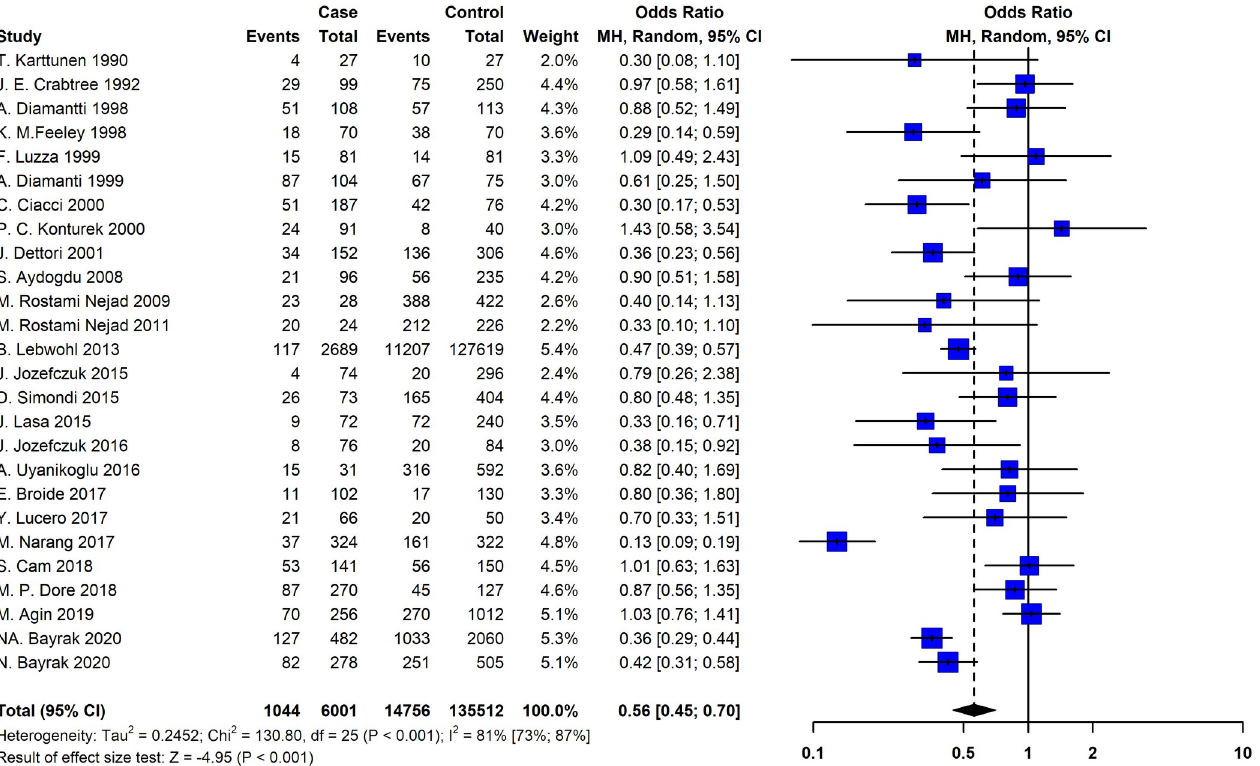
Fig 2. The Forest plot of the meta-analysis on the association of the Helicobacter pylori and celiac disease. The random-effects model was used to calculate pooled ORs with 95% CI. CI, Confidence interval; OR, Odds ratio.